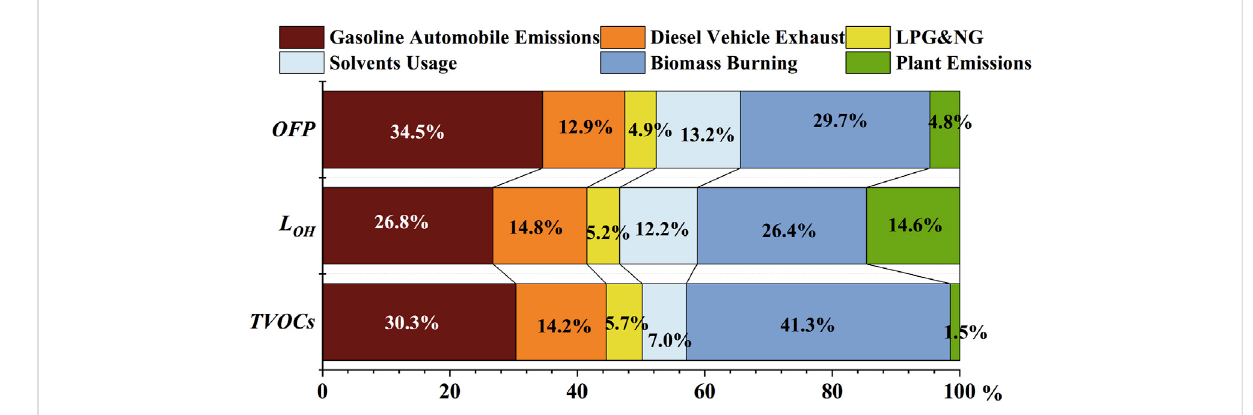
FIGURE 11 The contribution of each source to TVOCs, L OH and OFP .